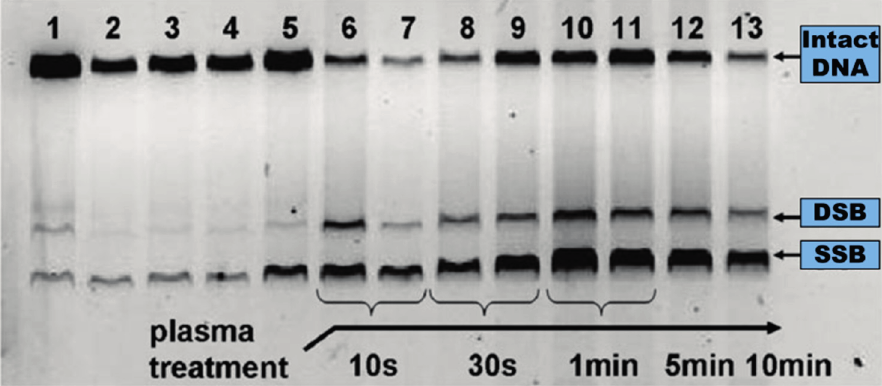
Figure 7. Typical image of agarose gel displaying thirteen samples of dry plasmid DNA treated under different conditions: (1) DNA in aqueous solution; (2) and (3) DNA placed on a mica substrate; (4) and (5) DNA placed on mica and treated with He gas; from (6) to (13) DNA placed on mica and treated by the APP jet at various exposure